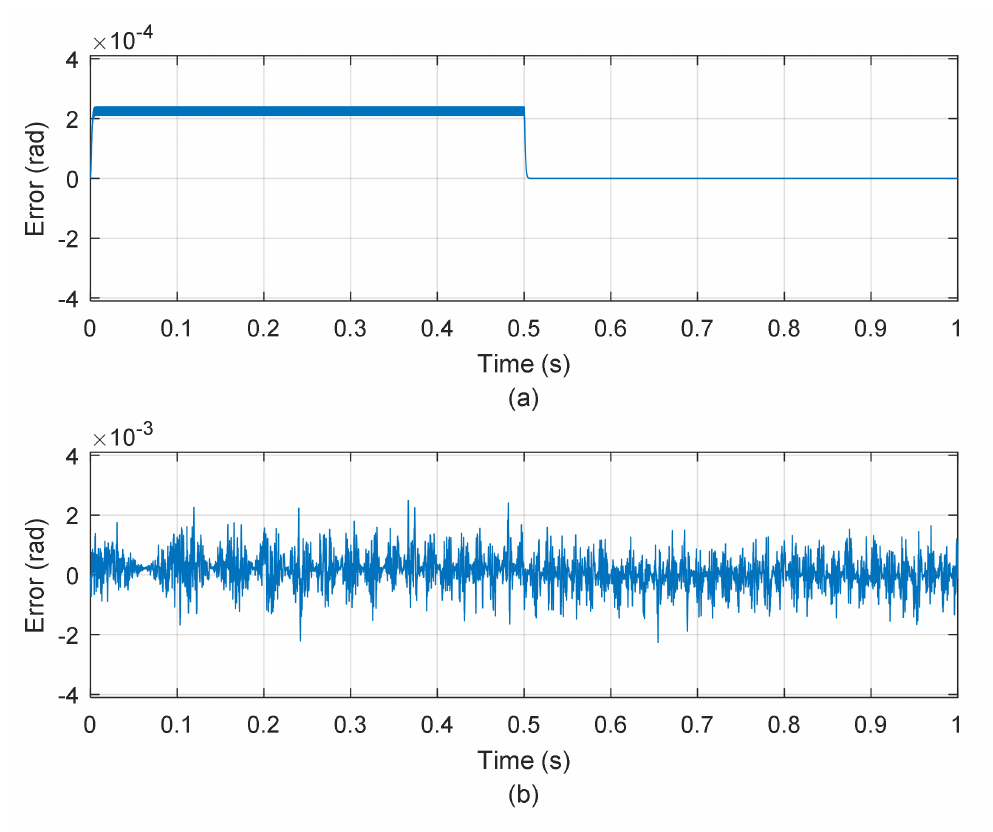
Figure 9. Simulation results for N p = 102, N c = 2, R w = 0.01. ( a ) Without noise; ( b ) with